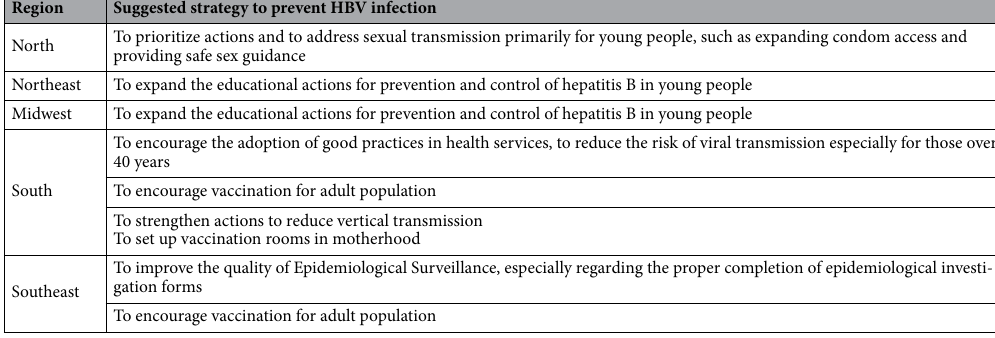
Region Suggested strategy to prevent HBV infection